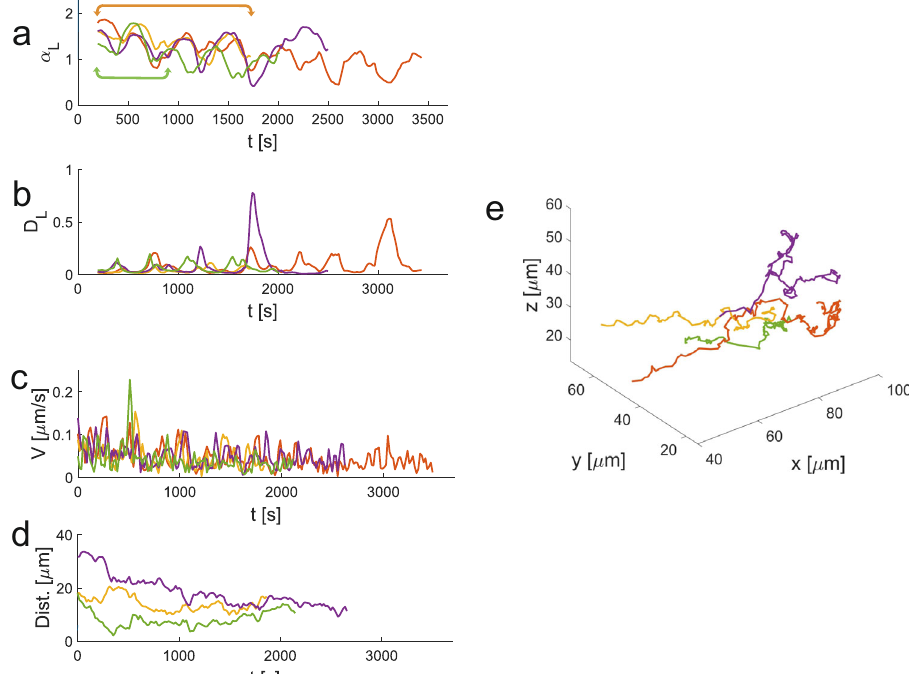
Fig. 5 Contact inhibition appears to lead to synchronization of hemocyte movement. Oscillations of local anomalous exponents ( a ), local generalized diffusion coef fi cients ( b ) and velocity ( c ) appear to synchronize when hemocytes experience contact inhibition. Arrows ( a ) highlight coherent portions of local anomalous exponents for different trajectories. The green trajectory was moving coherently with other trajectories for 900 s. Red, violet and yellow trajectories were coherent for approximately 1700 s. Hemocytes during contact remain in close proximity to each other performing a dance of anomalous diffusion. d Shows the relative distance between contacted hemocytes depicted in ( e ) and the red